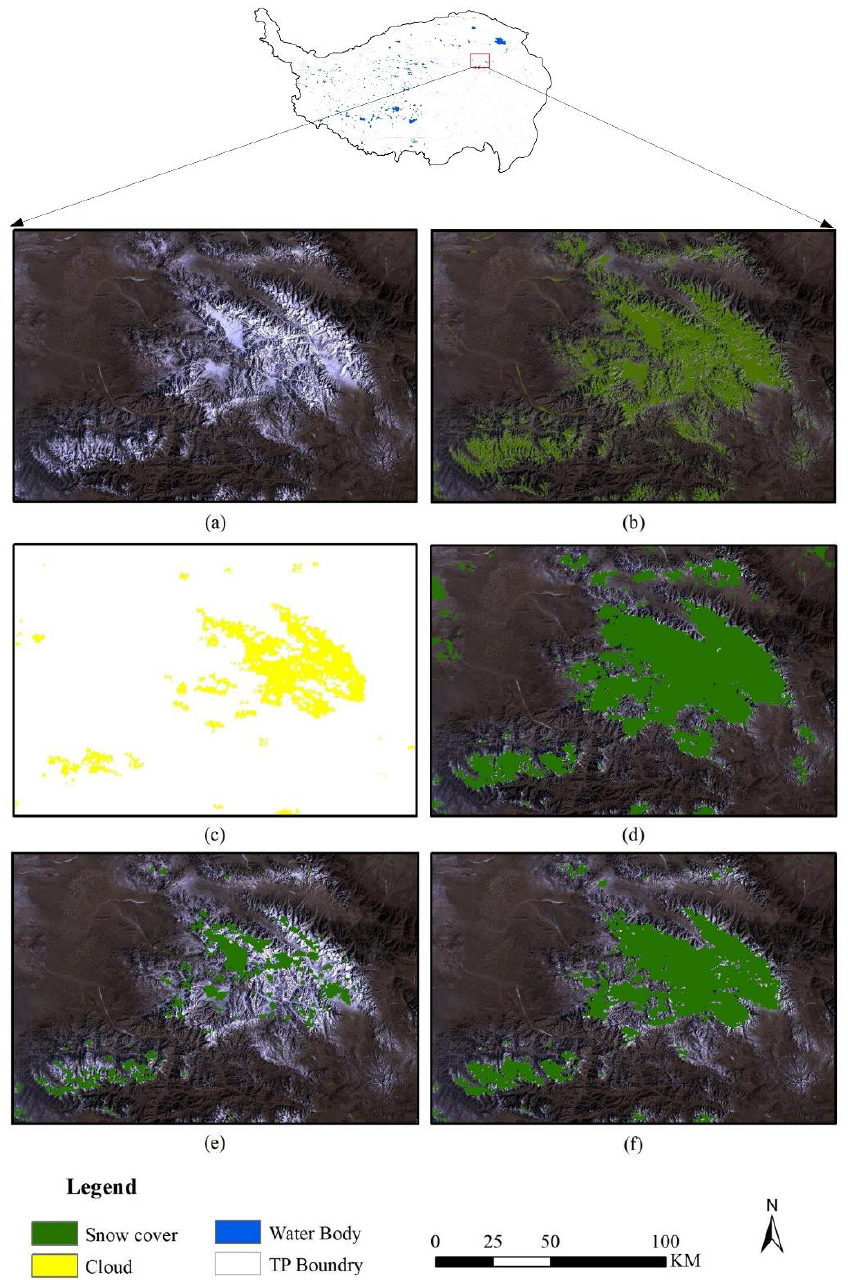
Figure 7. Partial enlarged picture in the northeast of QTP on 6 January 2003 ( a ) Landsat TM true color image (image ID: LT05_L1TP_134035_20030106_20161206_01_T1), ( b ) Landsat TM snow cover distribution (green), ( c ) The cloud distribution (yellow) retrieved from MOYD, ( d ) The snow cover distribution (green) retrieved from SC2, ( e ) The snow cover distribution (green) retrieved from SC3, ( f ) The snow cover distribution (green) retrieved from SC1. SC1, SC2, and SC3 were the snow cover products of the combined MOD10A1F and MYD10A1F (SC1) developed by Huang et al. [28] and Qiu et al. [29], respectively.